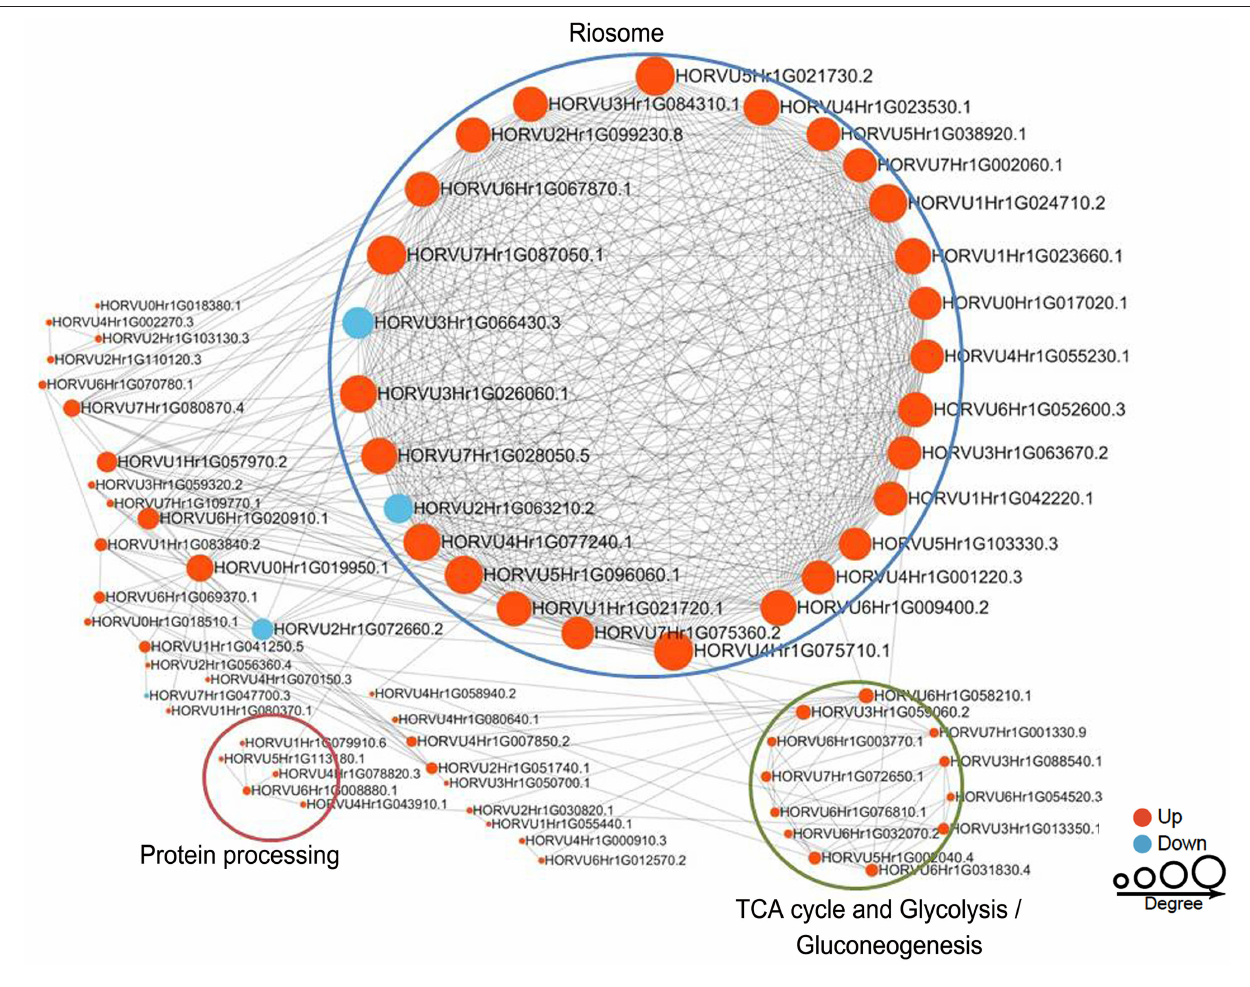
FIGURE 8 | Protein–protein interaction (PPI) network of succinylated proteins in response to Pi starvation. All DFASPs were searched against the STRING database (version 10.5) for PPIs and visualized using Cytoscape (version 3.6.1; http://www.cytoscape.org/). We collated all interactions with a high confidence score ( > 0.7). A graph-theoretical clustering algorithm, molecular complex detection (MCODE), was used to analyze densely connected regions. The circle size represents the numbers of DFASPs; red indicates increased and blue indicates decreased DFASPs. Further details are in Supplementary Table 10